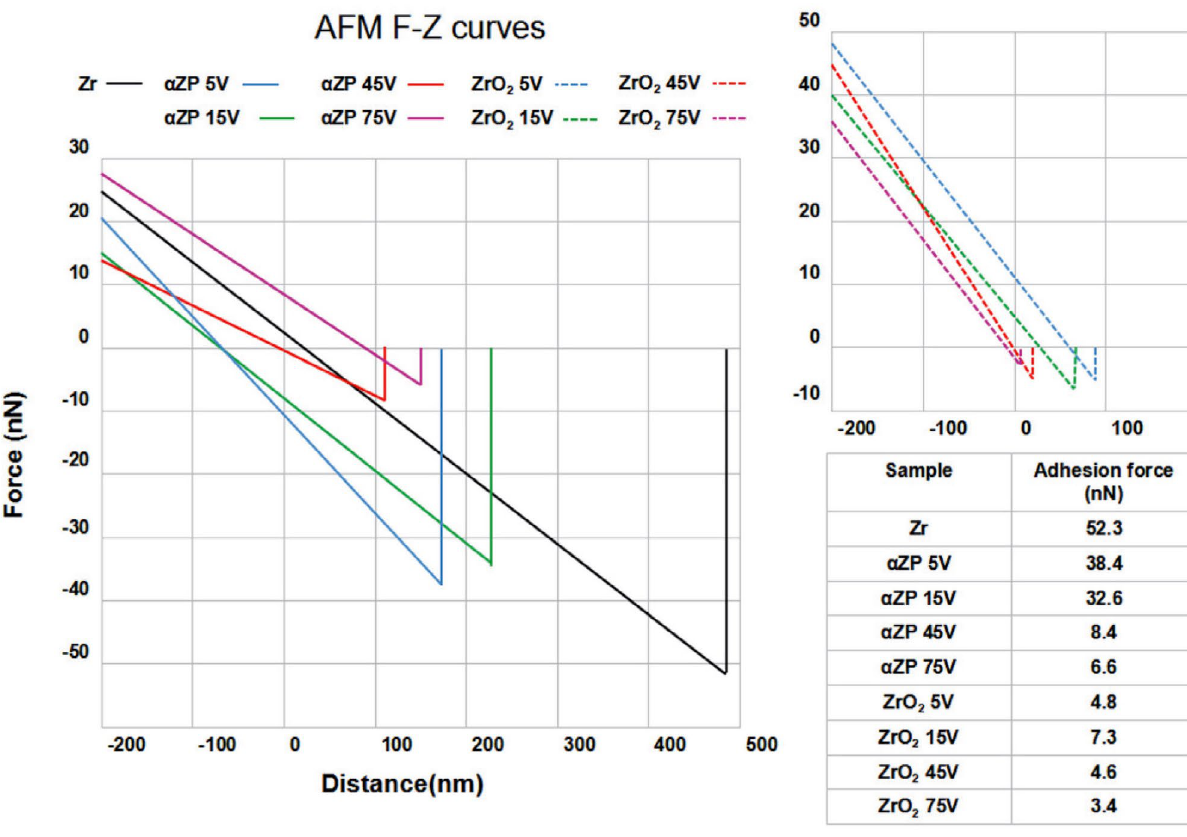
Fig. 6 Normalized median values for AFM tip adhesion forces (F-Z